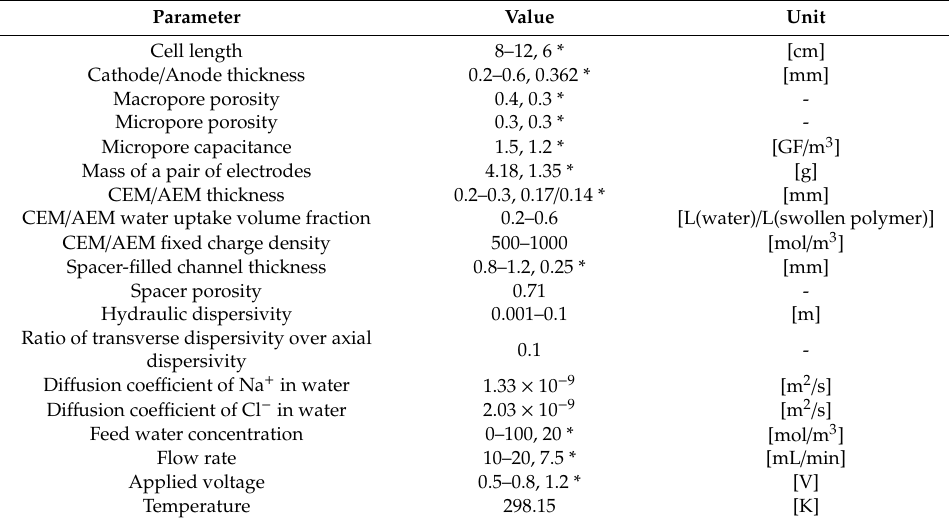
Figure 2. Two-dimensional MCDI assembly in this model. Table 1. MCDI device parameters and operating